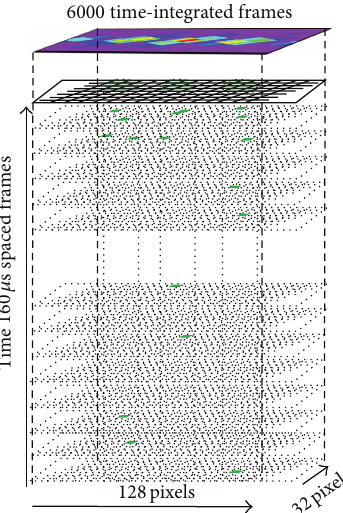
Figure 34: Pictorial view of the stack of frames collected in a typical two-slit interference